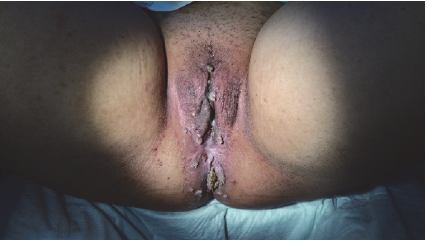
Figure 1: Genital warts in vulvar and anal region.